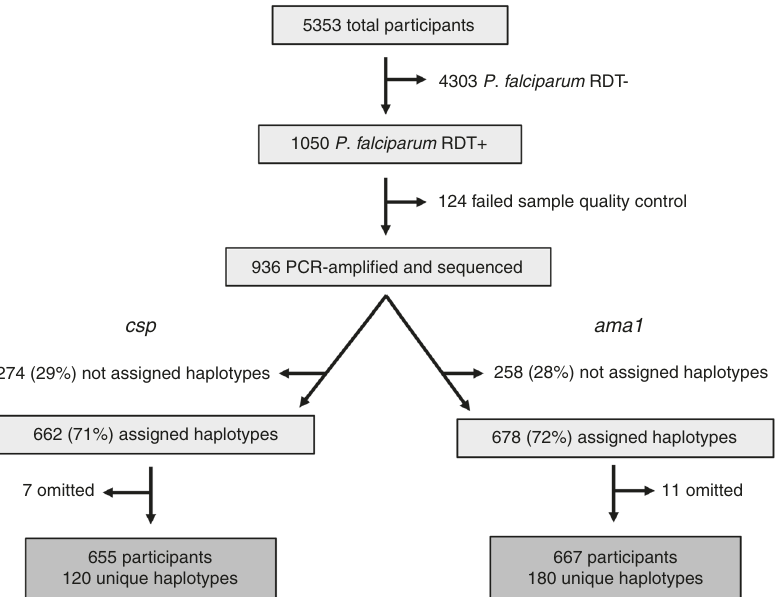
Fig. 1 Study setup, sequencing, and haplotype calling. All P. falciparum RDT + subjects were selected for PCR ampli fi cation and sequence analysis. Amplicons within both csp and ama1 hypervariable membrane proteins were sequenced. Approximately 30% of samples at both loci failed haplotype assignment due to low number of sequencing reads. csp sequencing data were excluded for seven study participants and ama1 data for 11 participants due to either data inconsistencies or erroneous sample tracking/identi fi cation. Table 1 Descriptive statistics for study participants who were RDT + and with successful csp / ama1 haplotype assignment. RDT + ( n = 1050) Assigned csp haplotypes ( n =